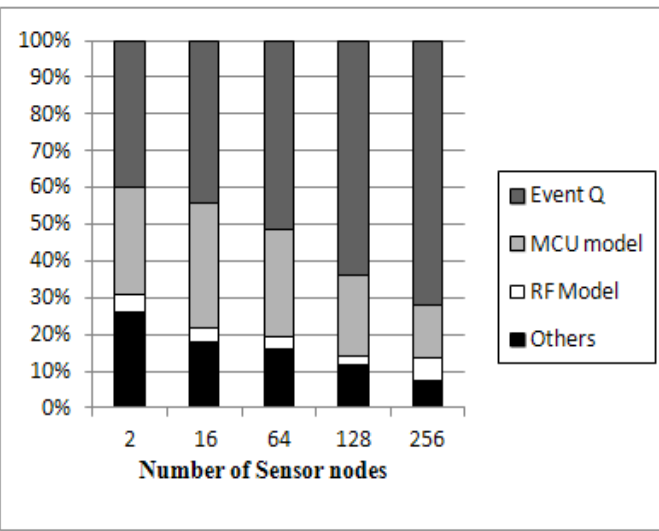
Figure 1. Profiling result of NQEM